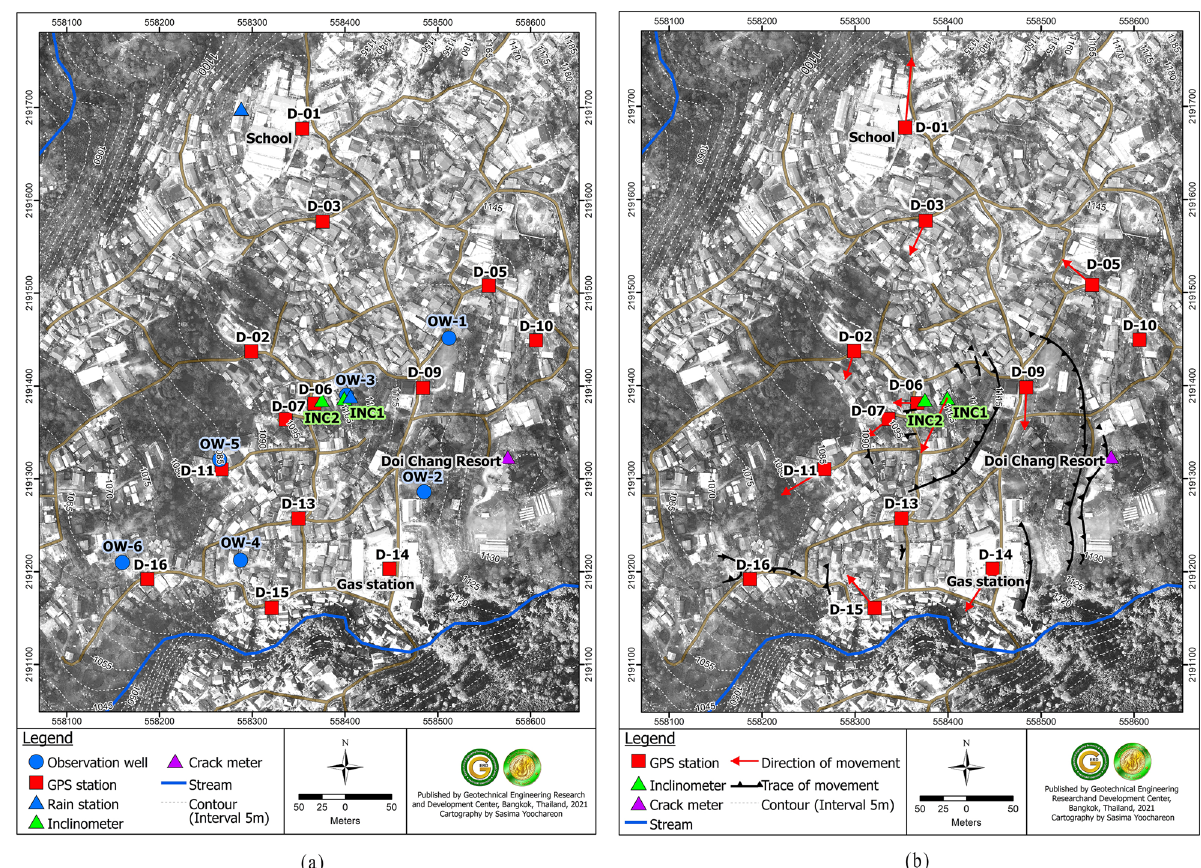
Figure. 2. ( a ) Instrumentation at the study site ( b ) Direction of the slope